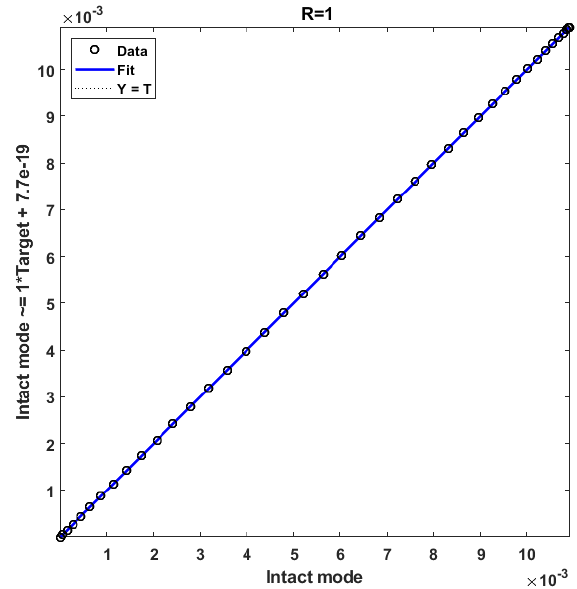
Figure 5. Regression diagram for two intact modes.